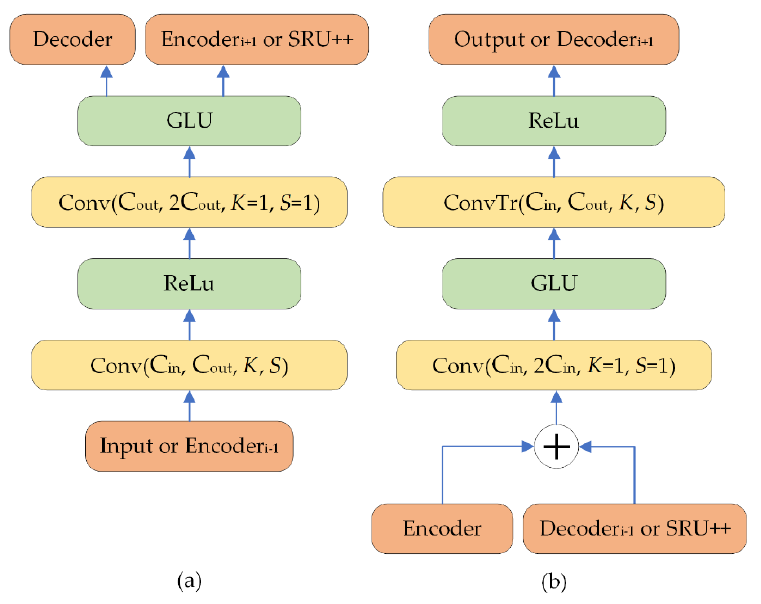
Figure 1. Detailed architecture of the encoder ( a ) and decoder ( b ) of VibDenoiser, where K stands for the kernel size and S stands for the stride. The arrows represent the flow of information.